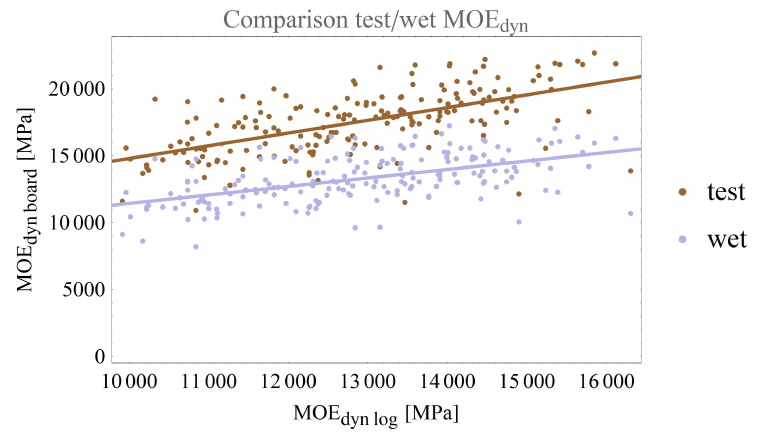
Figure 10. Comparison of the frequencies of logs and the frequencies of wet and dry boards.